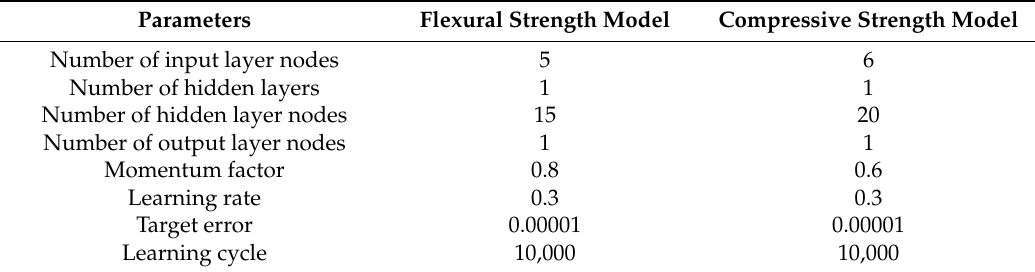
Table 4. Parameters used in the ANN